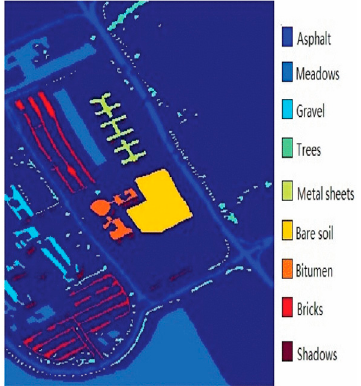
Figure 3. Ground truth of the Pavia University data set.